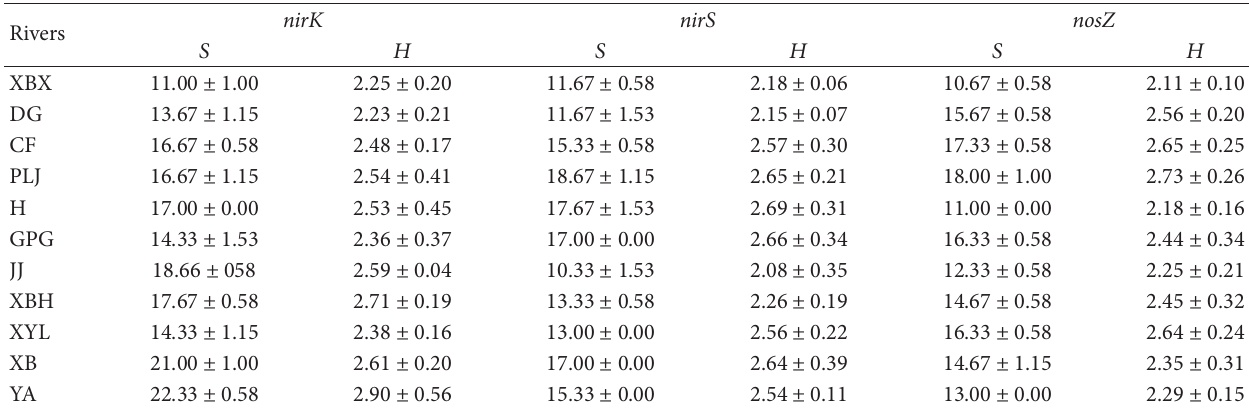
Table 3: Shannon ( 𝐻 ) and richness ( 𝑆 ) values of nirK , nirS , and nosZ